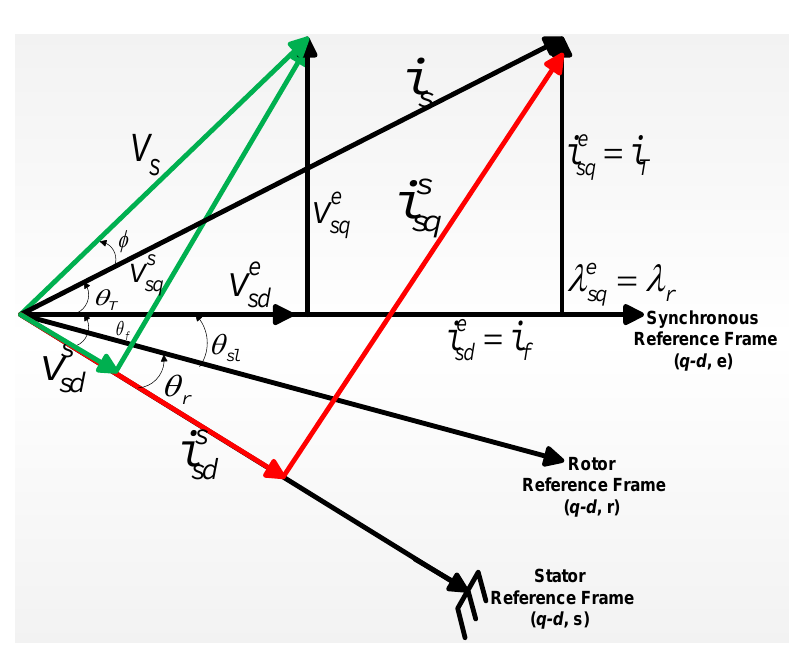
Figure 2. Indirect Field Oriented Controller Phasor Diagram [24,25].